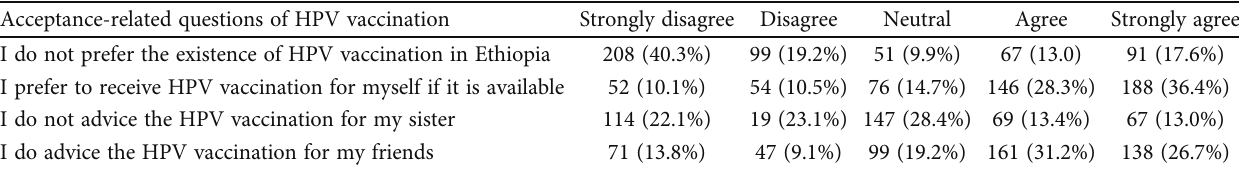
Table 4: Acceptance of HPV vaccination among girl students in Arba Minch town, Southern Ethiopia, 2020. Acceptance-related questions of HPV vaccination